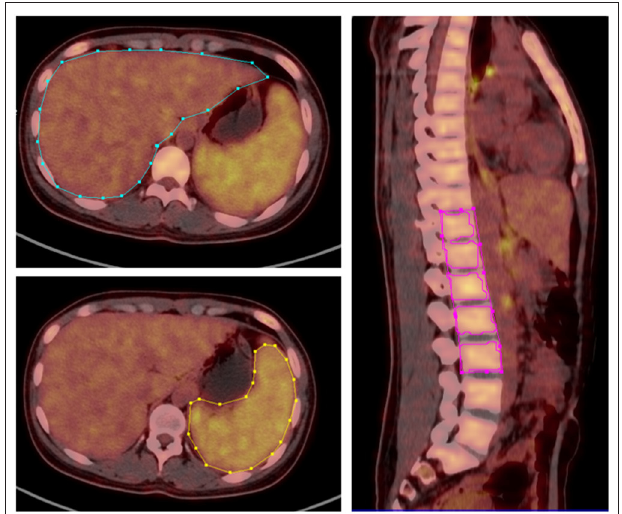
FIGURE 1 | 3D ROI was manually delineated according to the contours of liver, spleen and spine, SUVmax, and SUVmean of corresponding regions was obtained.